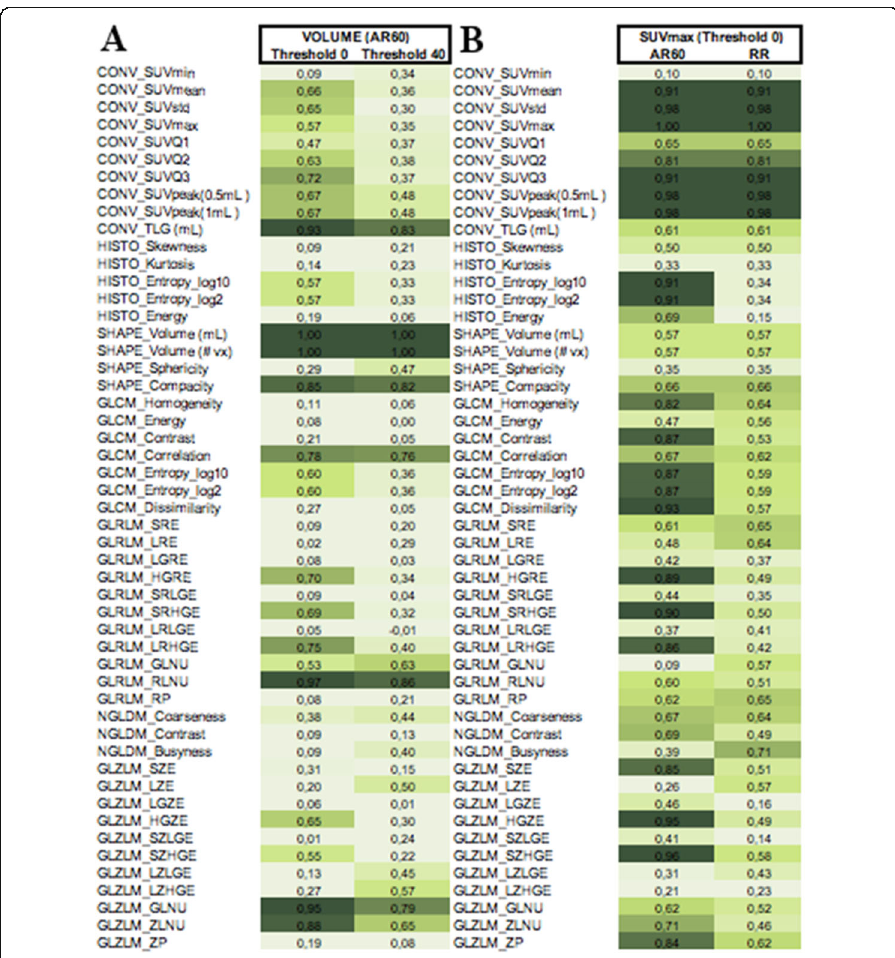
Fig. 7 Pearson correlation coefficients (mean values between different operators) respectively ( a ) between RFs values and volume (for no threshold and 40% SUV max threshold applied); and ( b ) between RFs and SUV max (for AR60 and RR intensity rescale factors) without threshold. TLG (total lesion glycolysis) conventional parameter in our study corresponds to the TLSRE (total lesion somatostatin receptor